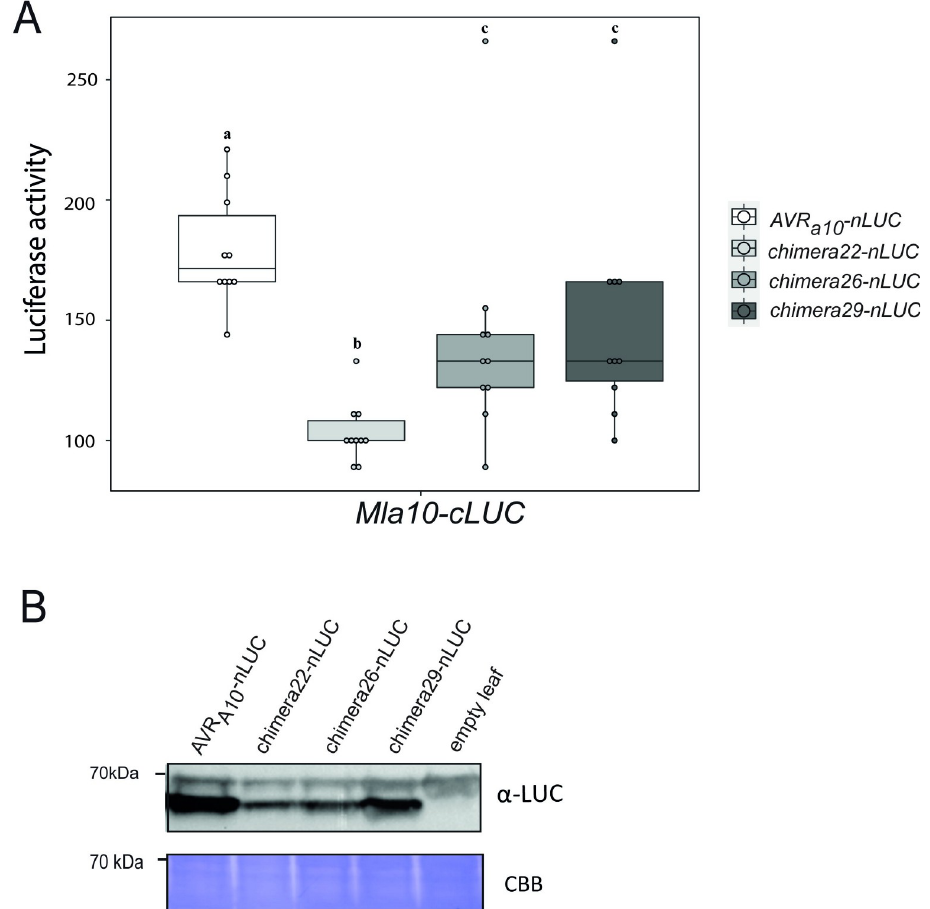
Fig 10. AVR A10 amino acid residues that are responsible for specific recognition correlate with residues that interact with the MLA10 receptor. (A) N . benthamiana plants were transformed transiently with vectors containing cDNAs of Mla10-cLUC together with cDNAs of AVR a10 -nLUC without signal peptide, chimera22-nLUC , chimera26-nLUC or chimera29-nLUC under the control of a 35S promoter. LUC activity was determined 40 h after A . tumefaciens -mediated transformation. The experiment was performed on at least four independent days with two to four replicates (independent set of plants) each day. Significant differences between samples were analyzed using non- parametric Kruskal-Wallis (KW) analysis followed by the Dunn’s test. Calculated KW p -value = 5.03e-05. Samples labeled with different letters differed significantly ( p < 0.05) in the Dunn’s test. (B) Protein levels of AVR A10 -nLUC, chimera22-nLUC, chimera26-nLUC and chimera29-nLUC. Proteins were separated on a 8% SDS_PAGE gel and a detected using anti-LUC western blotting